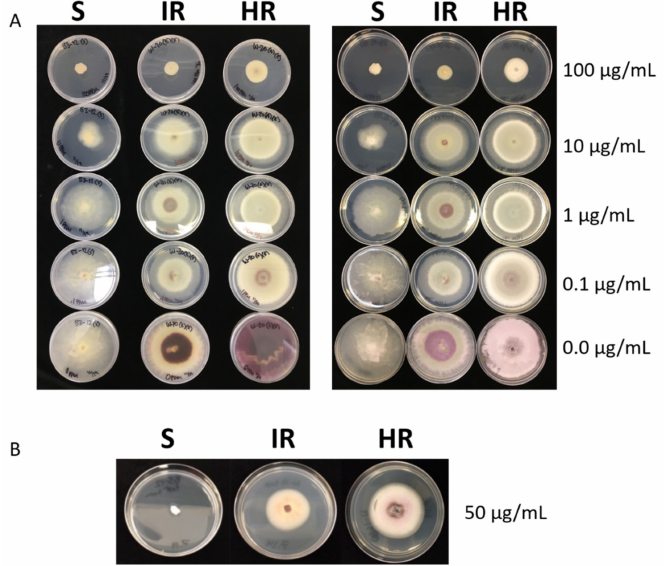
Figure 1. Phenotypic growth assay. ( A ) Growth assay on decreasing levels of prothioconazole- amended media from 100 to 0 µ g/mL. Both sides of the media and growth are shown. S = Sensitive isolate, HR = Highly resistant isolate, IR = Intermediately resistant isolate. ( B ) The same isolates grown at 50 µ g/mL prothioconazole to show the morphological differences. All plates are from 14 days post-inoculation.